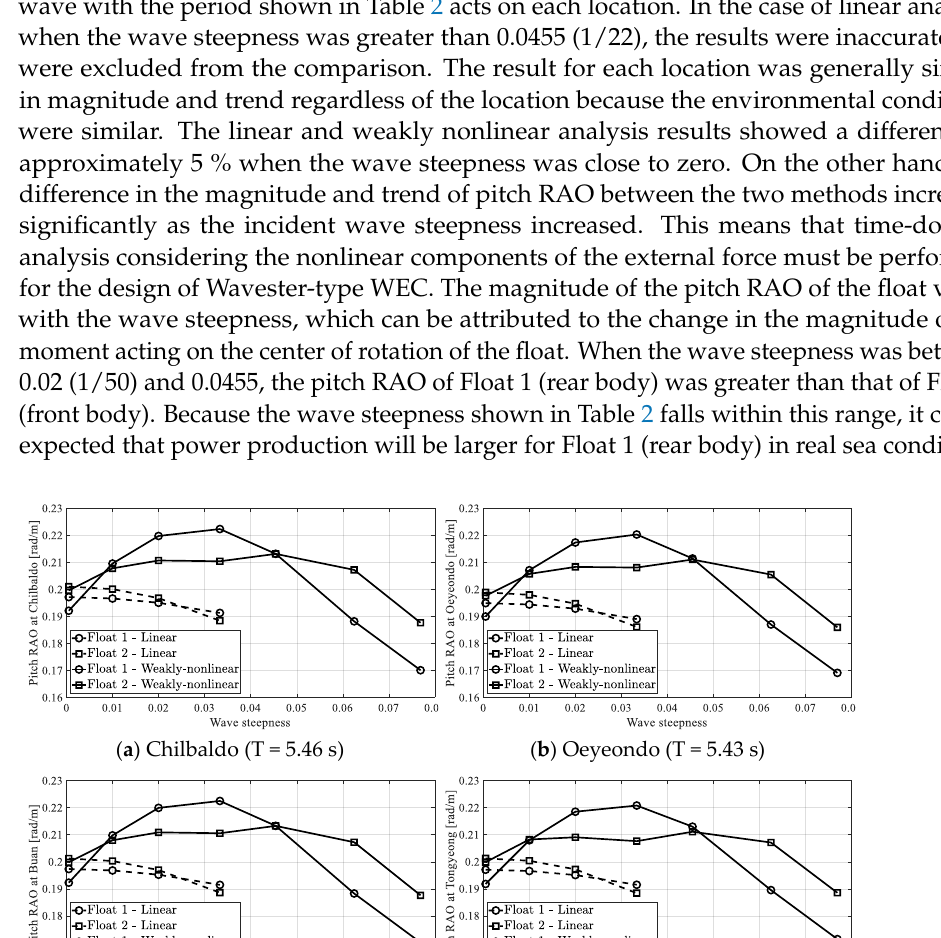
Figure 14. Comparison of the pitch RAO according to the distance between hinge points at Chilbaldo (H = 1.26 m, T = 5.46 s).